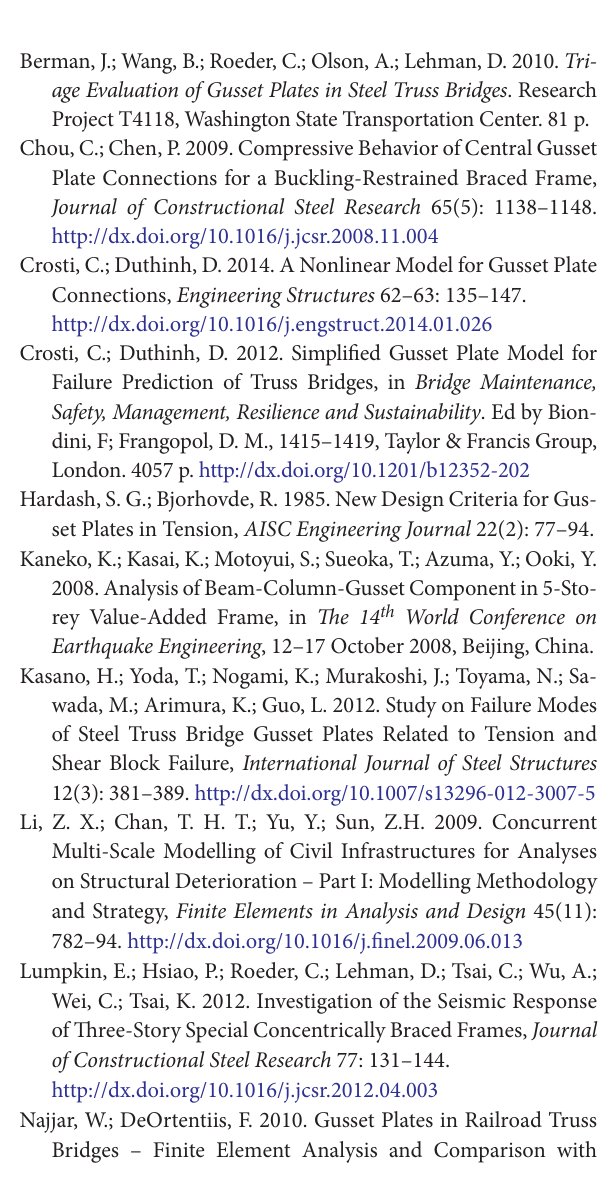
Fig. 25. H-M equivalent stress in β - β